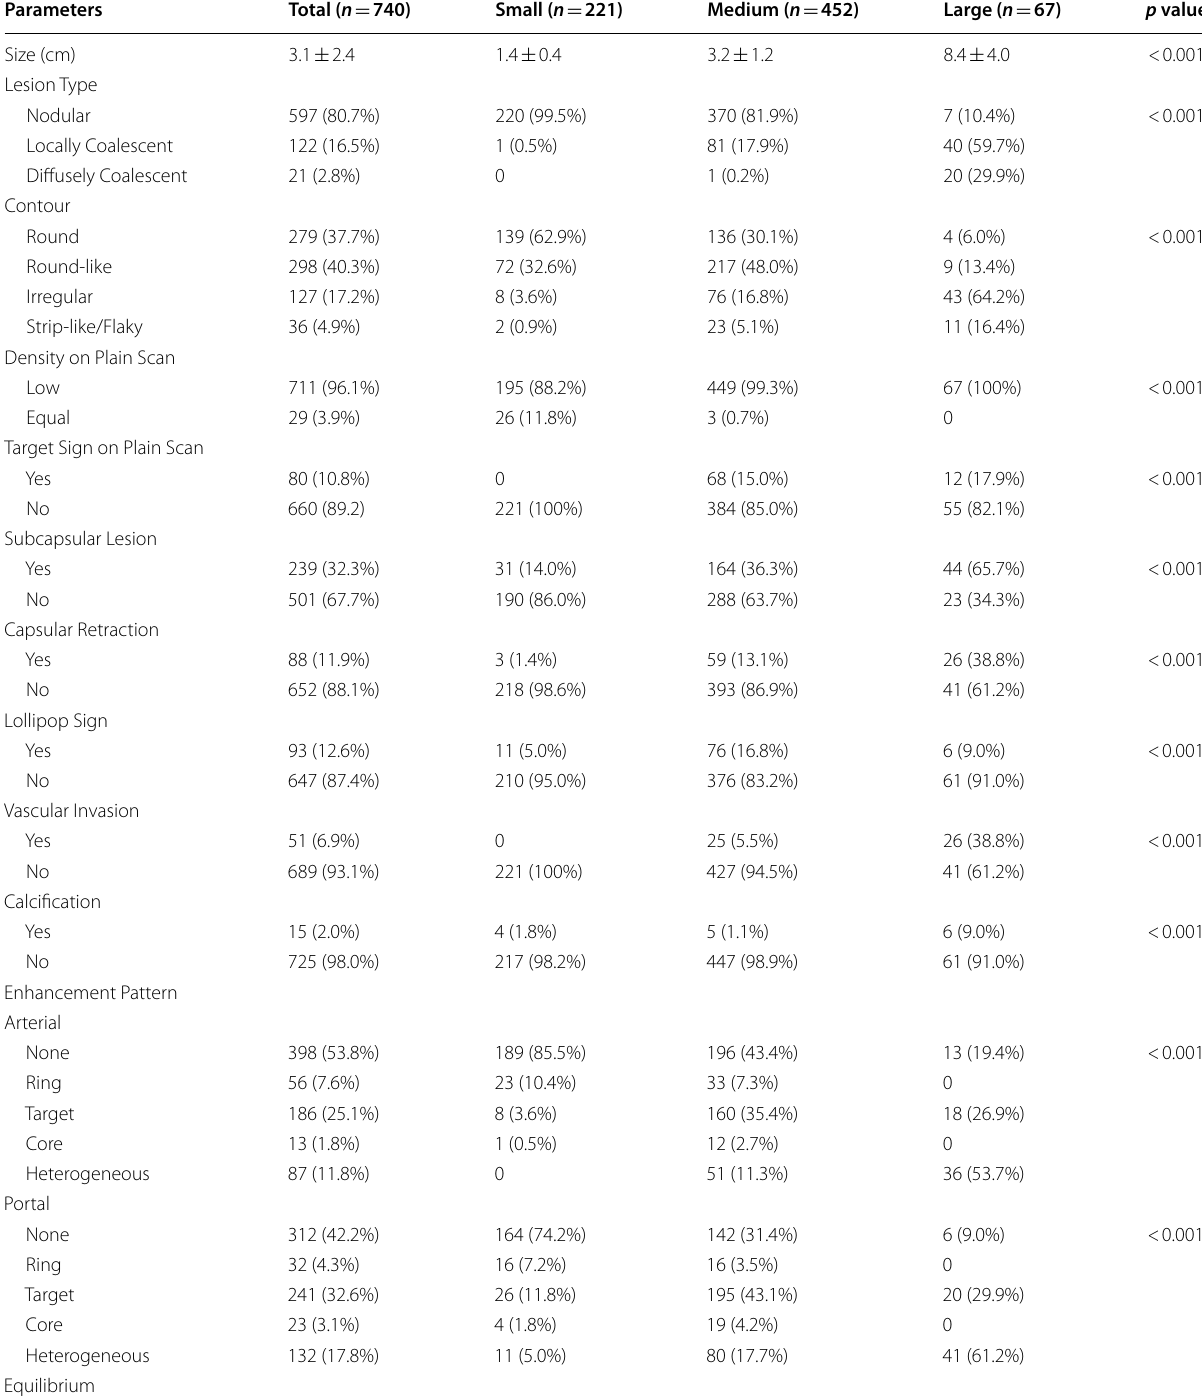
Table 2 Comparison of CT appearances of HEH lesions among different size groups